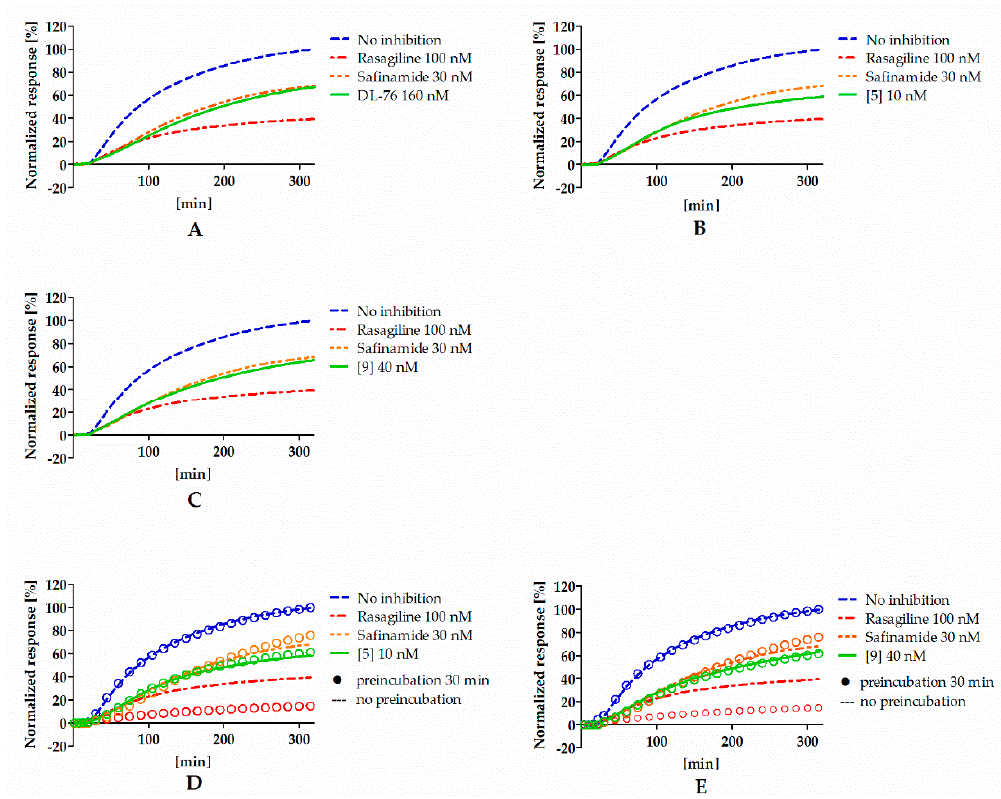
Figure 3. Reversibility of DL76 ( A ), 5 ( B ), 9 ( C ), and reference inhibitors without the preincubation and comparison of reversibility of 5 ( D ), 9 ( E ), and reference inhibitors that were (rings) or were not (lines) preincubated with hMAOB. Concentrations of compounds correspond to their IC 80 values.